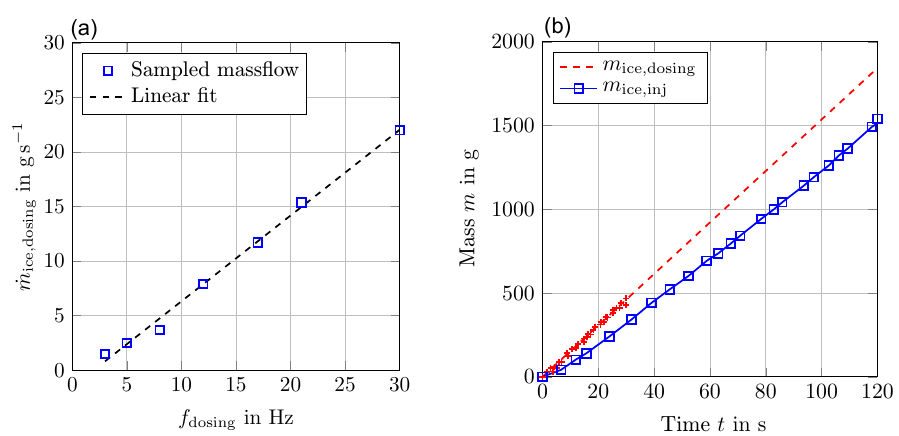
Figure 17. Ice particle massflow, (a) dependence on dosing machine frequency and (b) ice particle supply over time at a dosing frequency of f dosing = 21 Hz.